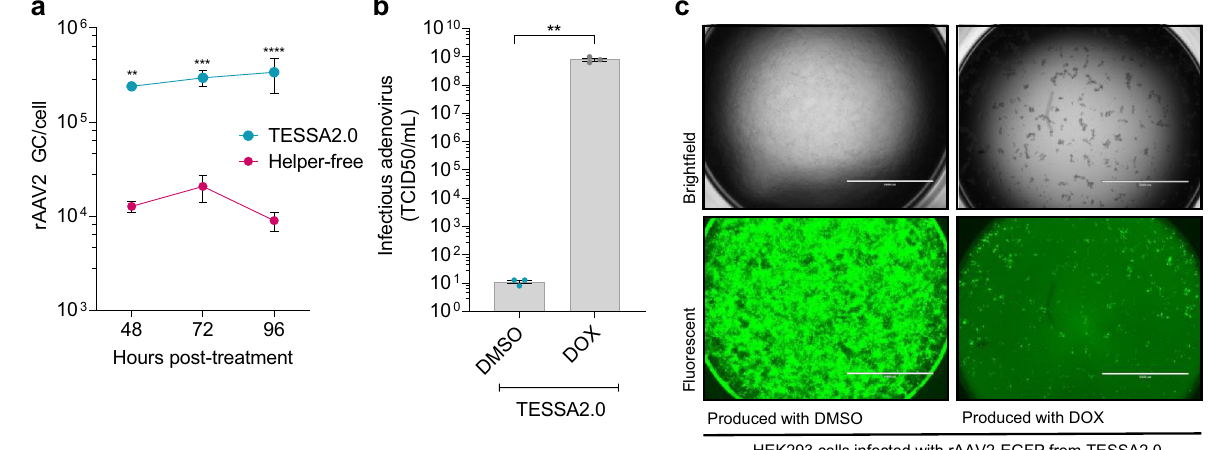
by quantifying infectious particles using a TCID50 assay in the presence of doxycycline. When doxycycline was present during manufacture, TESSA went through the full adenoviral life cycle, giving 8 × 10 8 TCID50/mL of infectious adenovirus. However, in the absence of doxycycline, the conditions used for rAAV manufacture, contamination fell by almost 10 8 -fold to just ~10 TCID50/mL (Fig. 2b). This almost complete absence of contaminating adenovirus was also con fi rmed by hexon-speci fi